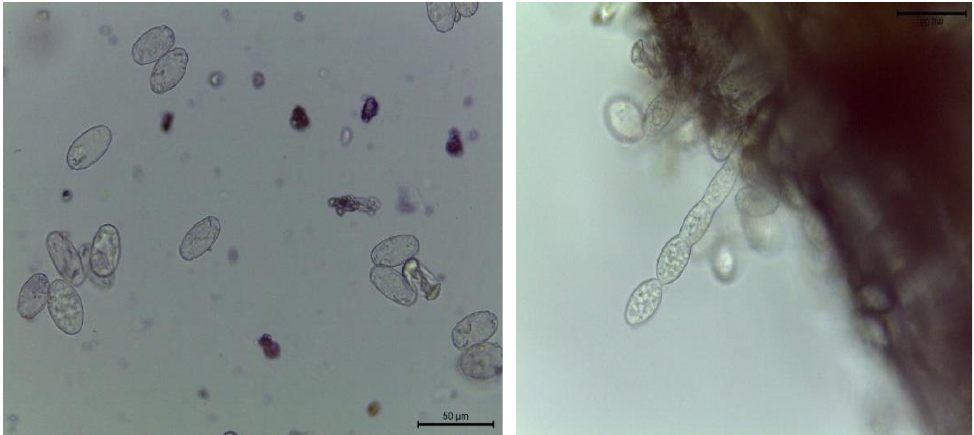
Figure 1. Morphological features of anamorphic stage of P. xanthii .